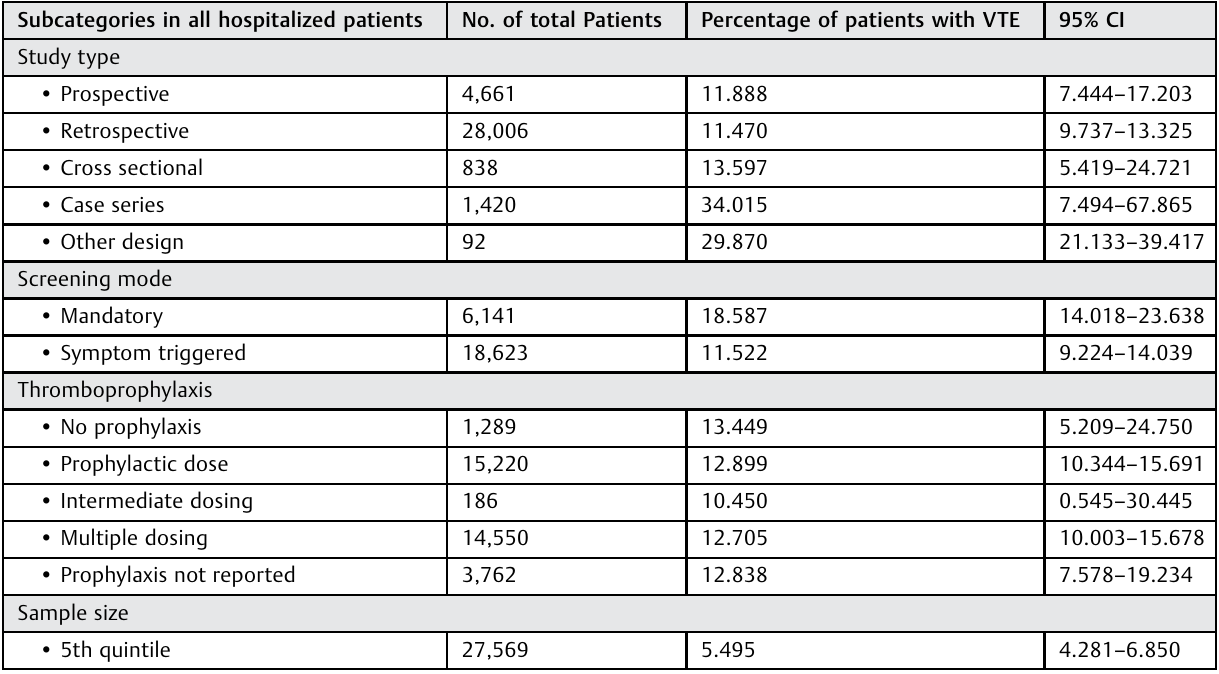
Table 3 Proportion of COVID-19 patients with venous thromboembolism: sensitivity analysis of all hospitalized patients Subcategories in all hospitalized patients